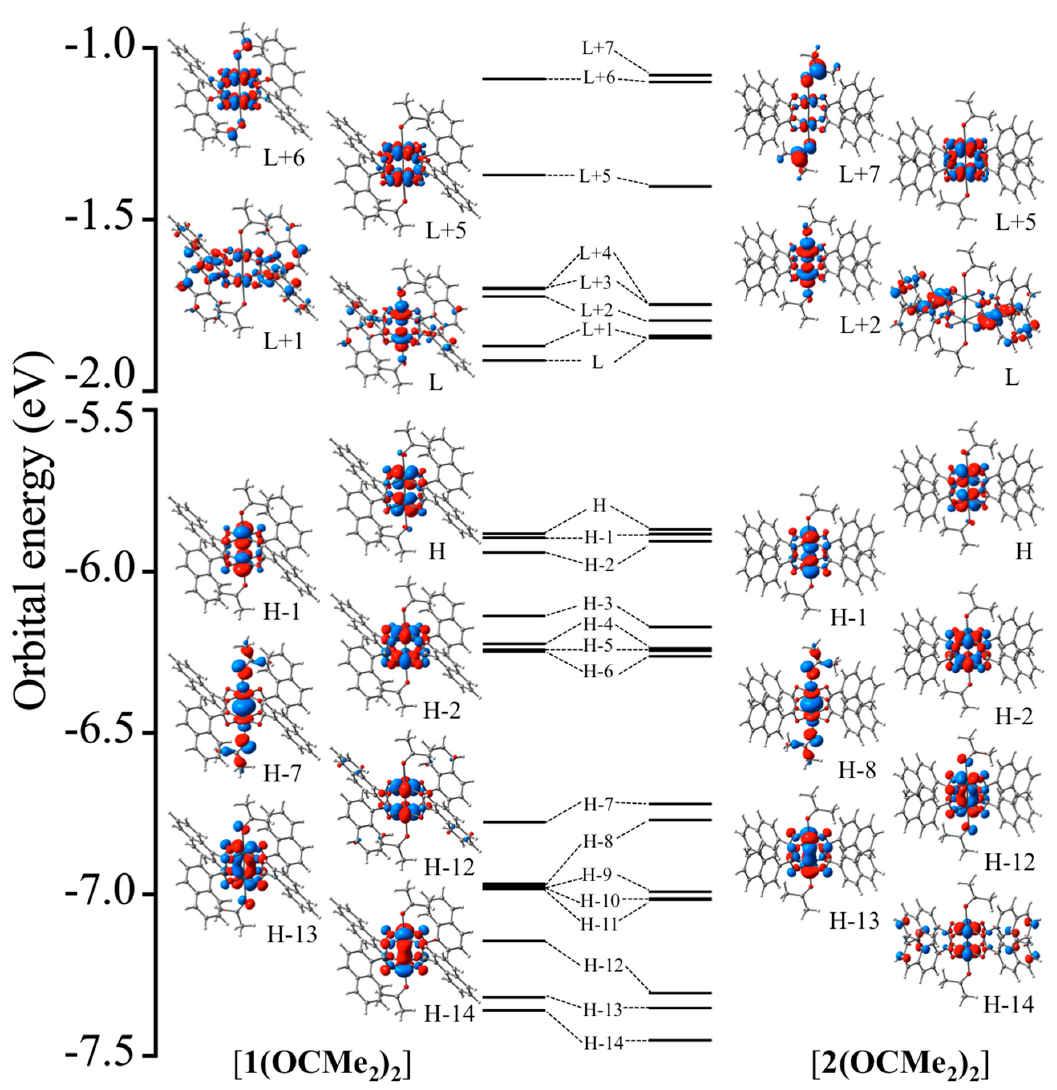
Figure 5. Molecular orbital (MO) energies and diagrams of [1(OCMe 2 ) 2 ] and [2(OCMe 2 ) 2 ] . Here, H and L are highest occupied MO (HOMO) and lowest unoccupied MO (LUMO),